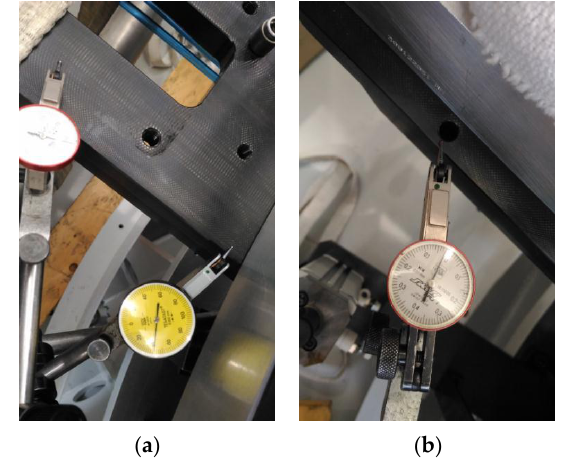
Figure 3. ( a ) Dial gauges at positions 1 and 3 and ( b ) at position 2.